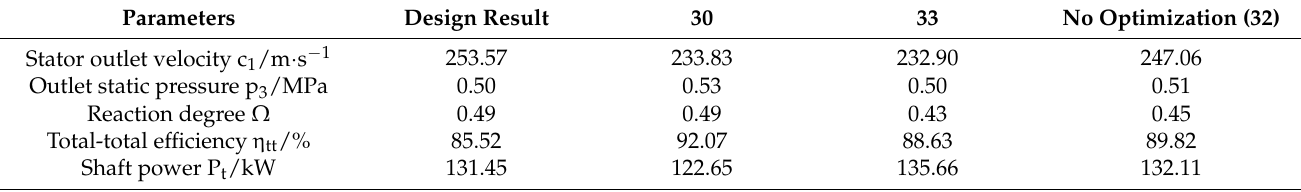
Table 4. Statistics and comparison of simulation data for the optimal number of stator